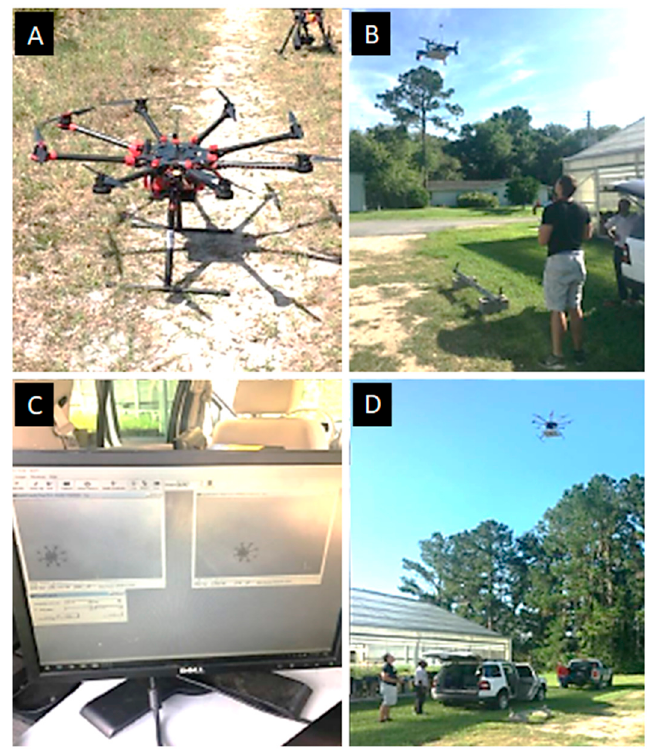
Figure 9. ( A ) The DJI S100+ COTS drone, ( B ) position hold test of the bridge inspection drone, ( C ) DIC image capture computer showing both camera images, ( D ) position hold test of the S1000+ drone .